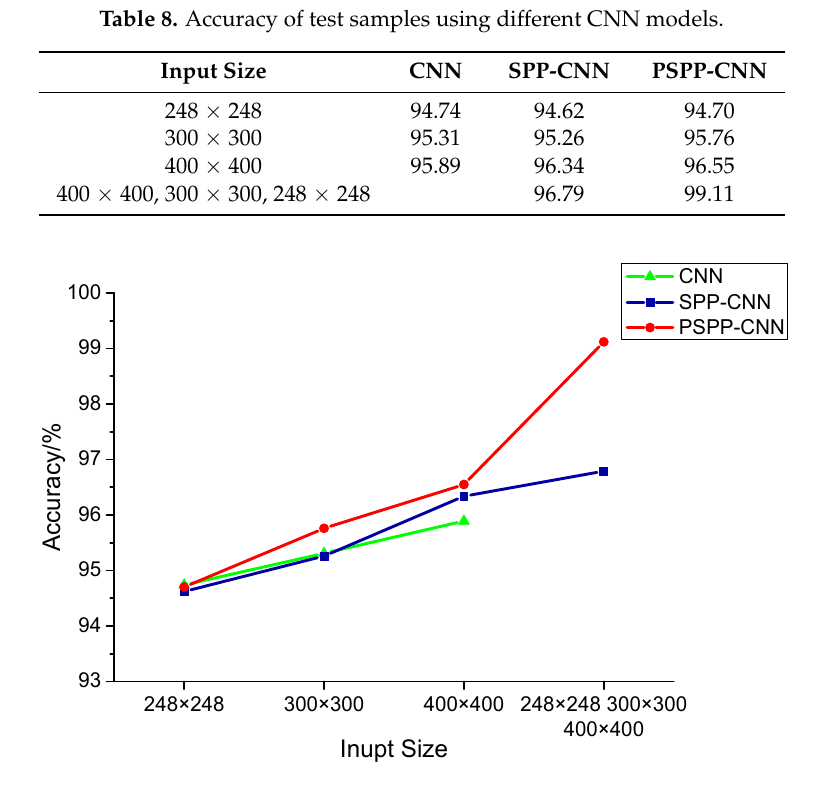
Figure 9. Accuracy of test samples using different input size and CNN models.